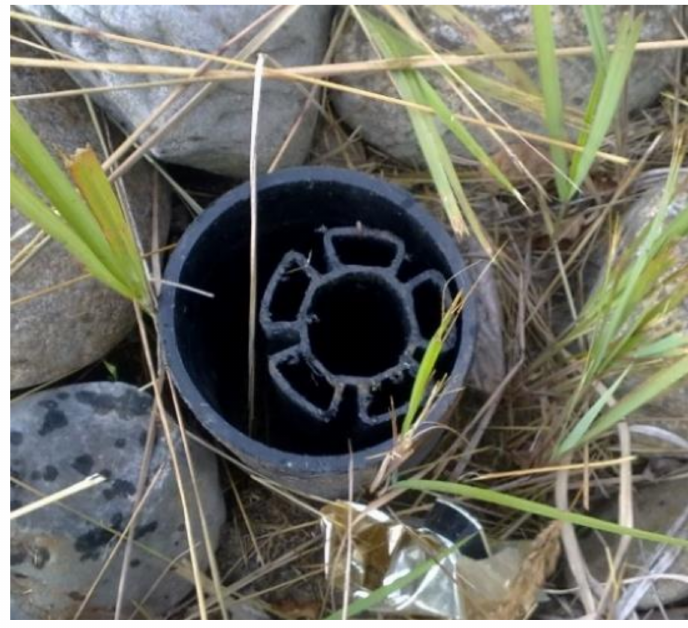
Figure 2. Profile of a Refla heat-collection pipe (A. Mäkiranta 2013). Sediment temperatures were measured using a distributed temperature-sensing (DTS) method in Suvilahti. A fiberglass cable was used as a linear temperature sensor. The cable was installed on the surface of one heat-collection pipe during the building process of the Housing Fair area. The total length of the cable temperature sensor was 300 m. The measurement device and calibration configurations are shown in Figure 3. Measurements were carried out once per month because of the delay in the air temperature influence on sediment temperature. Sediment heat temperature data used in this analysis were recorded during the years 2013–2016 and for only one month in 2018.